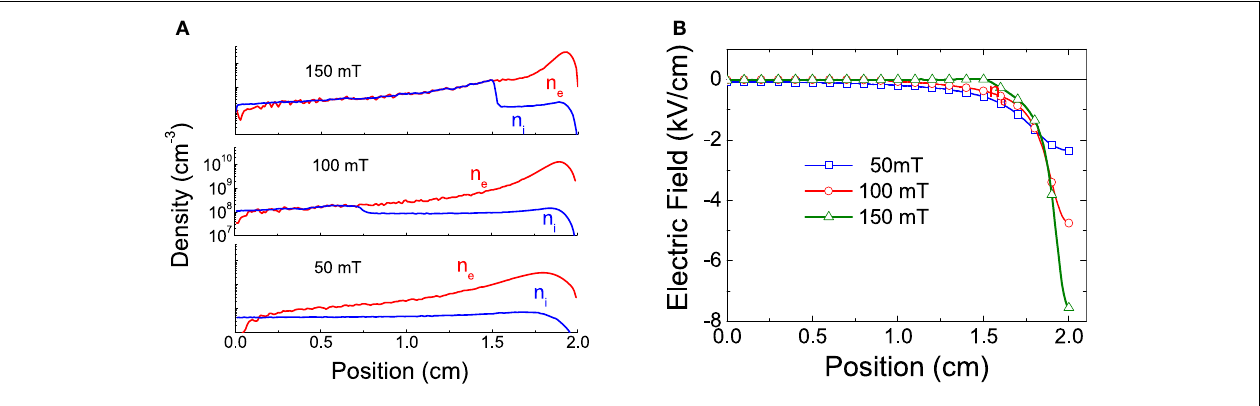
FIGURE 2 | (A) distributions of the electron and ion densities between cathode and anode, and (B) of the electric field in a magnetized discharge in argon, 0.05mTorr, 1kV applied voltage and